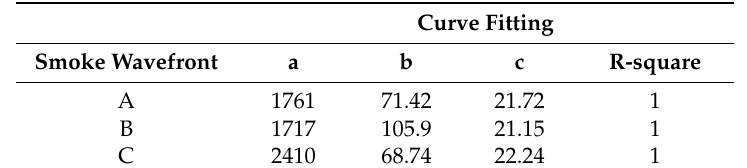
Table A1. Parameters for Gaussian fit for smoke wavefront.